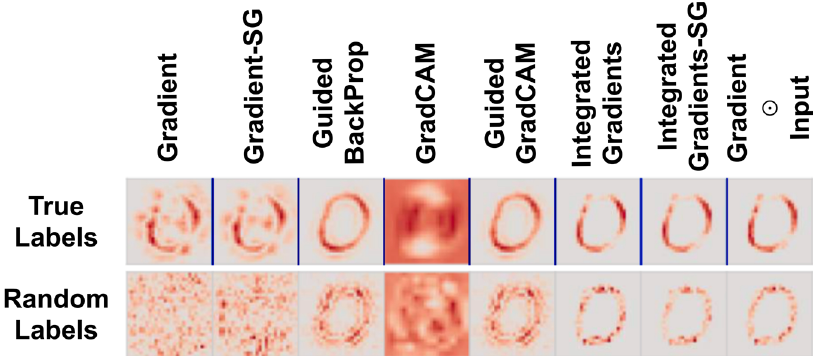
Fig. 17 Illustration for explanation invariance to data label randomization. A CNN is trained on two different datasets separately. The fi rst dataset is normal. The second dataset contains the same data entries as the fi rst dataset but the data labels are permutated randomly. The true-labels dataset trained model achieves high training and high test accuracy. The random-labels dataset trained model achieves high training and no better than random accuracy. Heat maps generated from the two CNNs are shown above. The training dataset is indicated in the row label and the explanation technique is indicated in the column label. Surprisingly, heat maps from the two models can be highly similar despite the dramatically different model generalization (i.e., test) performance. Figure reprinted from ref. 134 with permission.